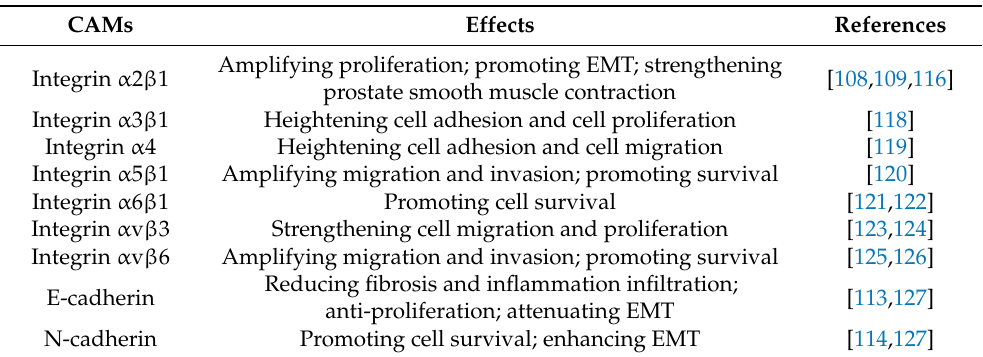
Table 1. Effects of CAMs on the